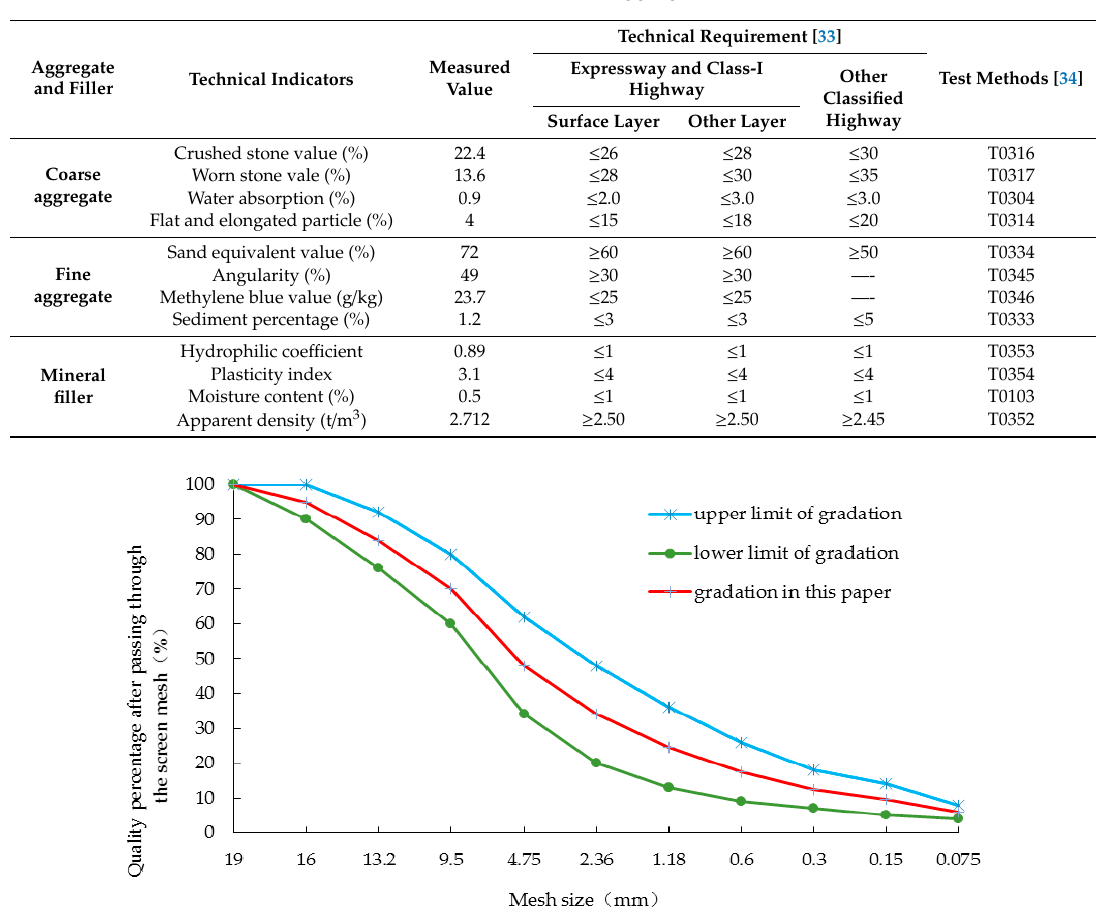
Figure 3. The grading curve of AC-16.